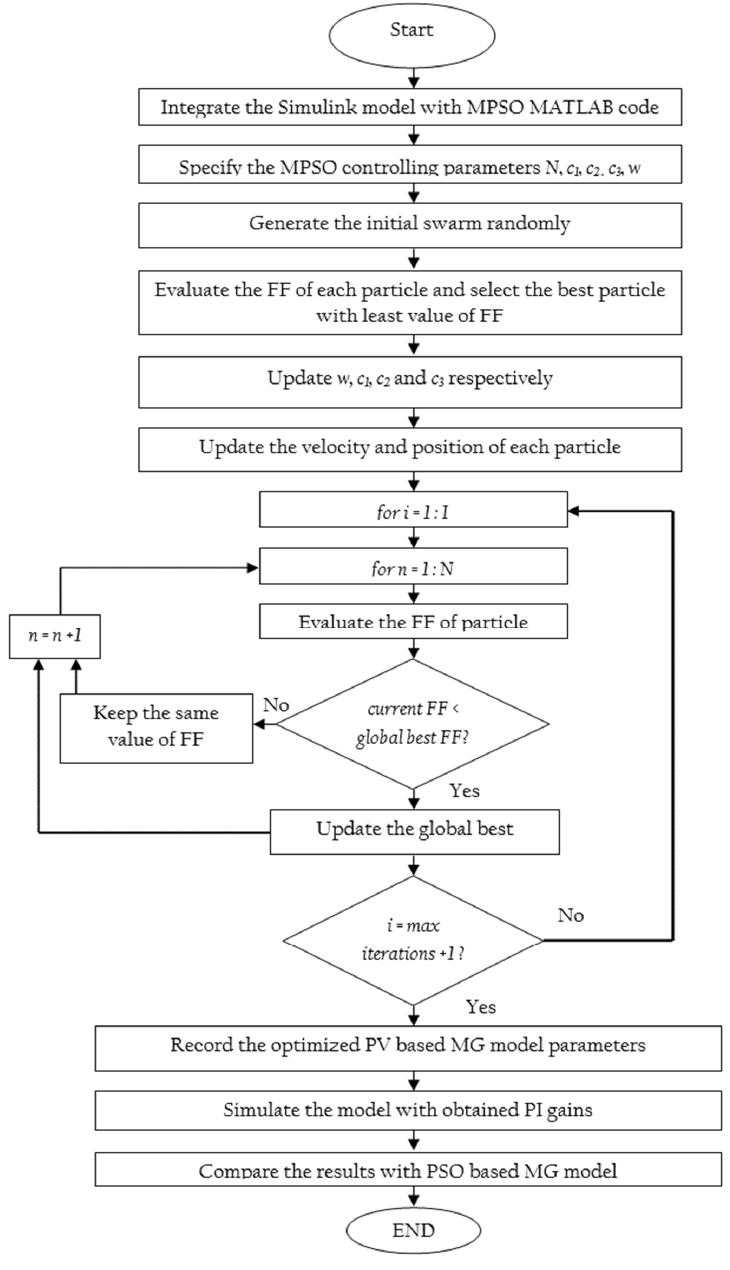
Figure 4. Proposed